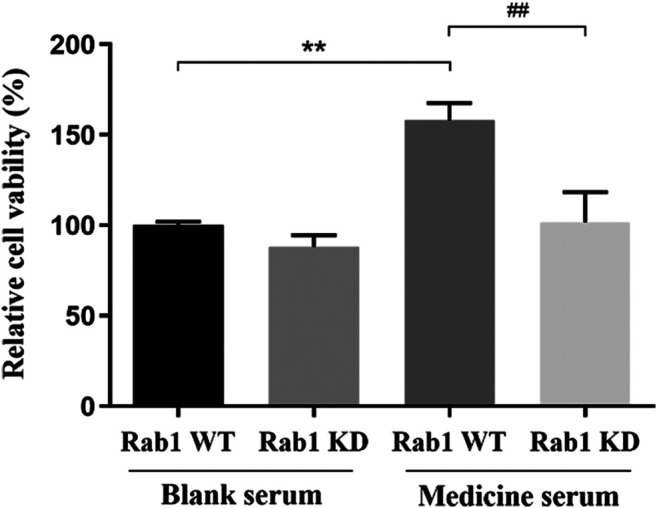
Effect of FYXN serum on the proliferation of BMECs, **p < 0.01 compared with NC + Rab1WT group; ##p < 0.01 compared with the FYXN + Rab1WT group.